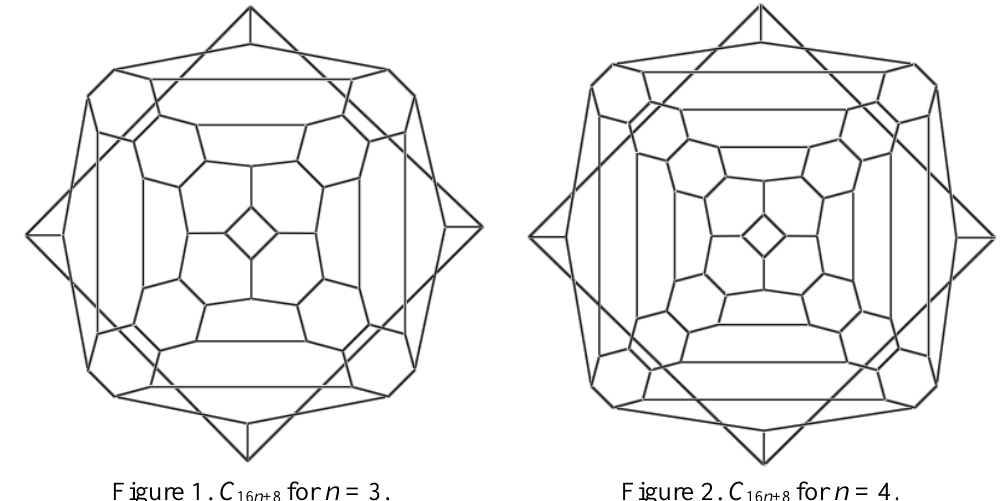
Figure 1. C for n = 3. Figure 2. C 16 n +8